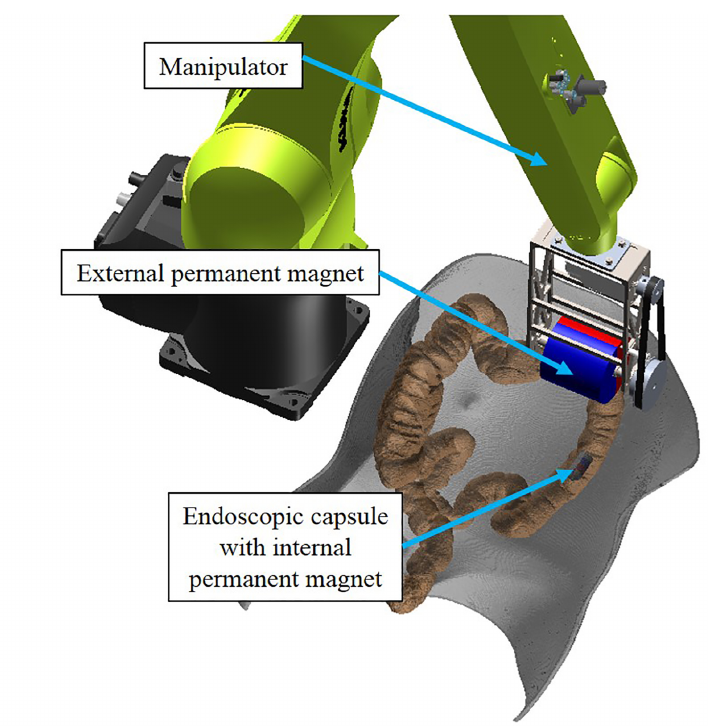
Figure 1. Generic working scenario of the magnetically-guided capsule colonoscopy.